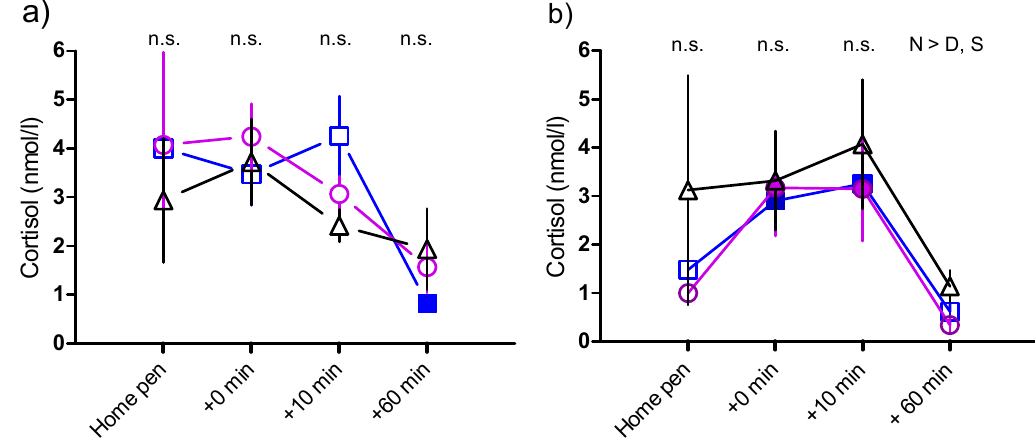
Figure 2. Saliva cortisol concentrations in nmol/L, (means ± SEM) in SEP kids ( ) DAY-SEP kids ( ) and NON-